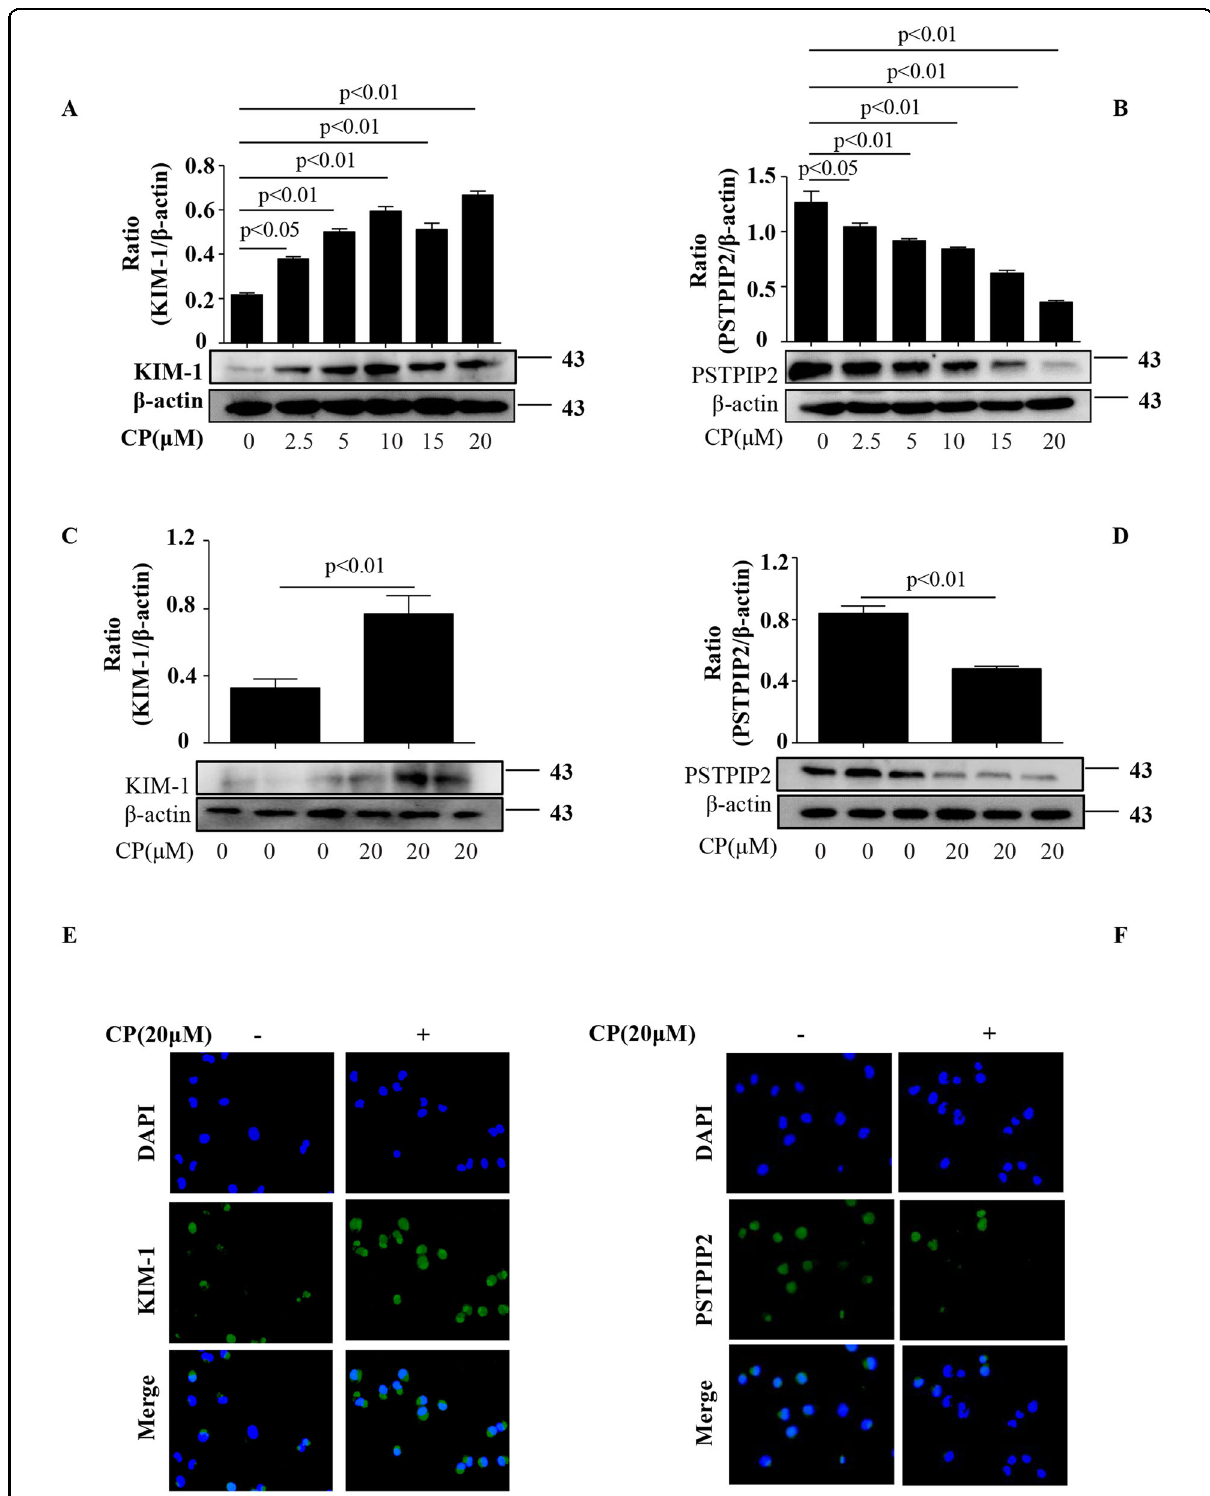
Fig. 2 PSTPIP2 was downregulated in CP-treated HK-2 cells. a Effects of various concentrations of CP on the expression of KIM-1 in HK-2 cells. b Effects of various concentrations CP on the expression of PSTPIP2 in HK-2 cells. c Effect of 20 μ M CP on the expression of KIM-1 in HK-2 cells detected by western blot. d Effect of 20 μ M CP on the expression of PSTPIP2 in HK-2 cells detected by western blot. e Effect of 20 μ M CP on the expression of KIM-1 in HK-2 cells analysed by immuno fl uorescence staining. f Effect of 20 μ M CP on the expression of PSTPIP2 in HK-2 cells analysed by immuno fl uorescence staining. Similar results were obtained in triplicate culture